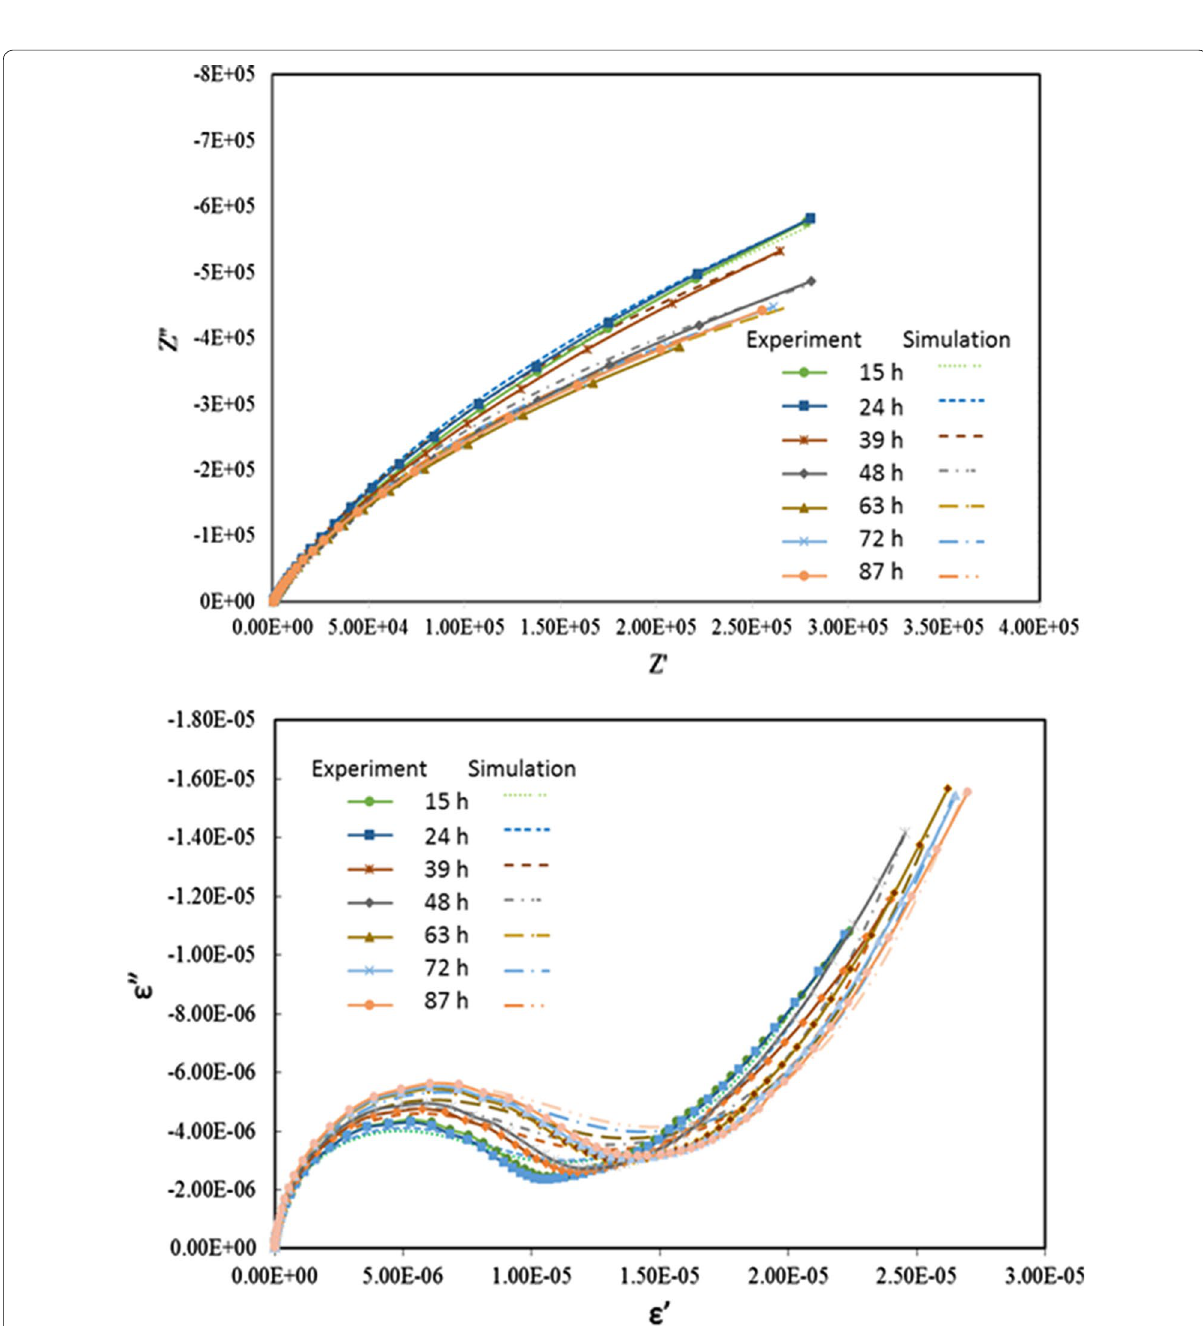
Fig. 5 EIS results of cultures of C. phytofermentans from both Bode (top) and Nyquist (bottom) plots during growth on cellobiose. The data were fitted to the equivalent circuit (Fig. 4) with good